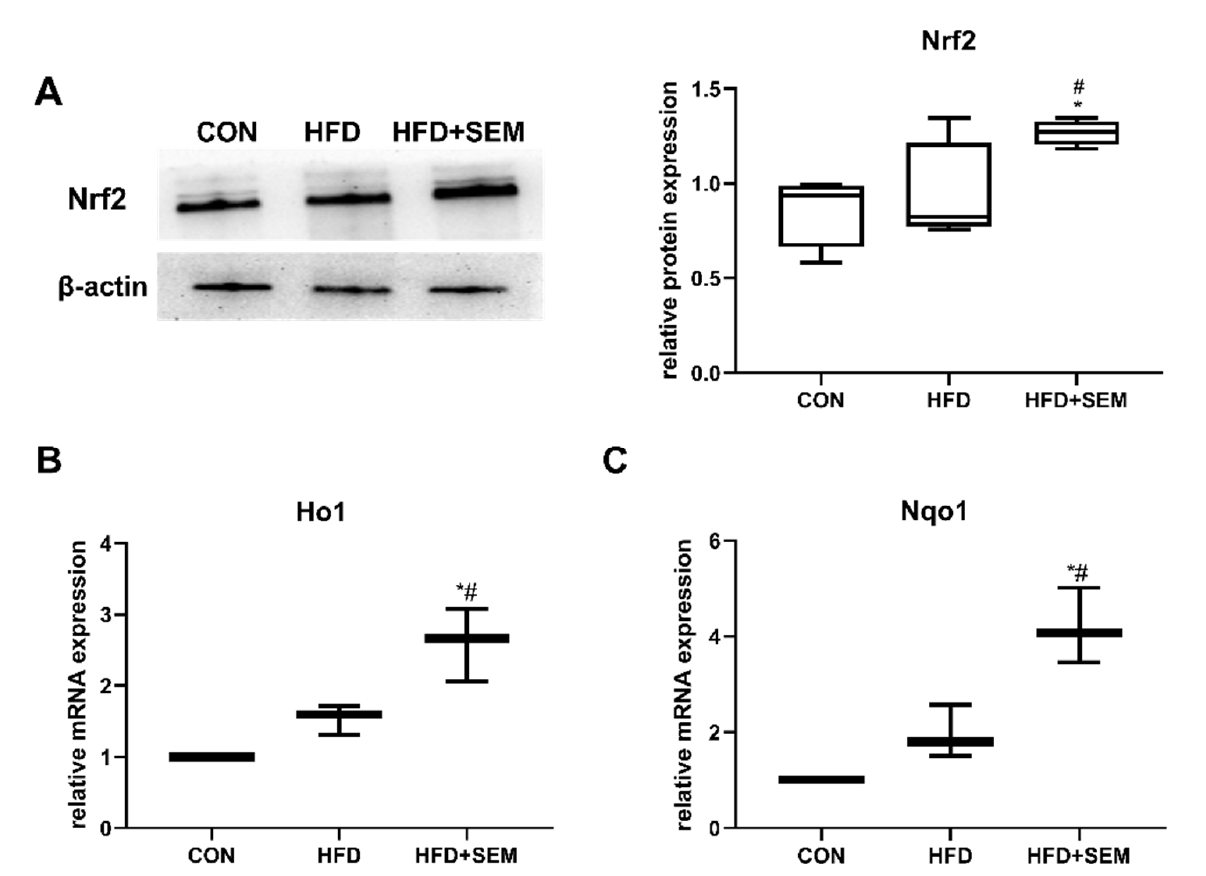
Figure 6. SEM prevents HFD-induced hepatic steatosis by modulating Nrf2 and its target genes Ho1 and Nqo1. Effects of HFD and HFD + SEM on hepatic ( A ) protein expression of Nrf2 and on relative mRNA expression of ( B ) Ho1 and ( C ) Nqo1. The relative intensities quantified by densitometry on western blots is presented in the panel on the right of the corresponding image. Data are presented as min to max in box-and-whisker diagrams and were analyzed with one-way ANOVA; * marks significant differences compared to the control group ( p ≤ 0.05); # marks significant differences between the HFD group and the HFD + SEM group ( p ≤ 0.05).